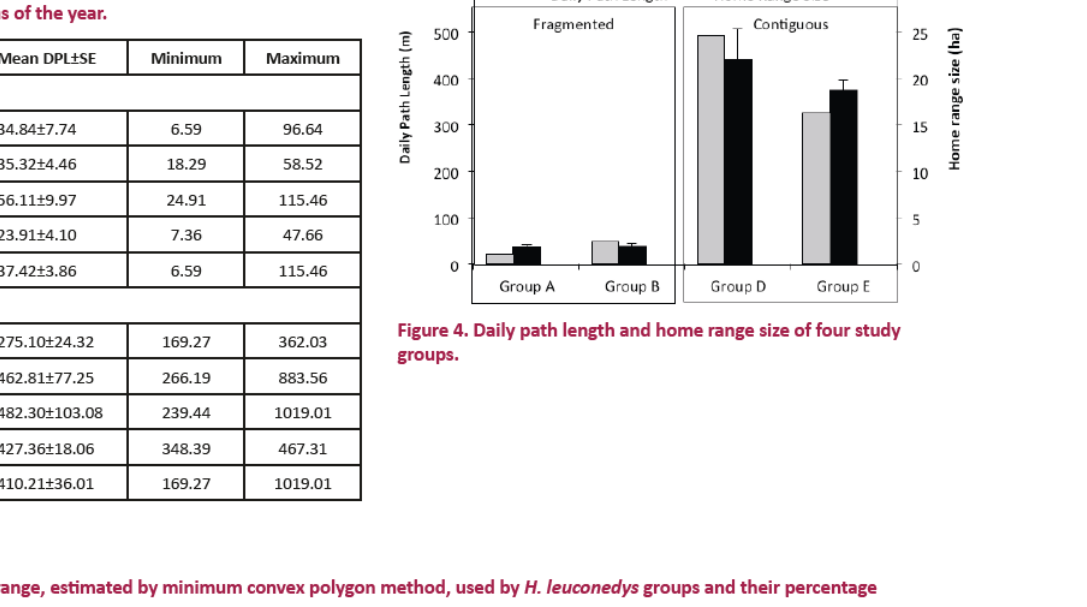
Table 3. Mean daffily patth lengtth (DPL) ffin ffragmentted and conffiguous fforestts across tthe seasons off tthe year.